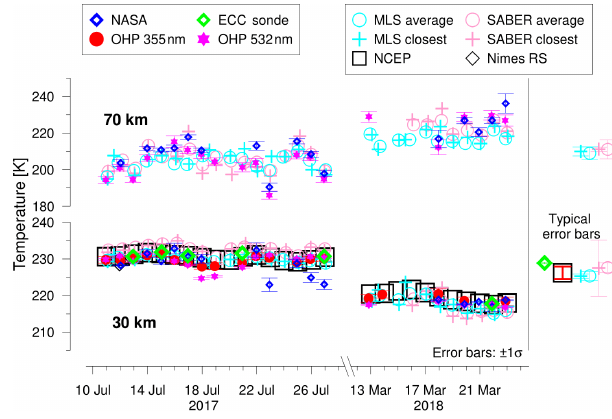
Figure 14. Time series of the temperatures measured by the differ- ent systems for selected altitude levels during